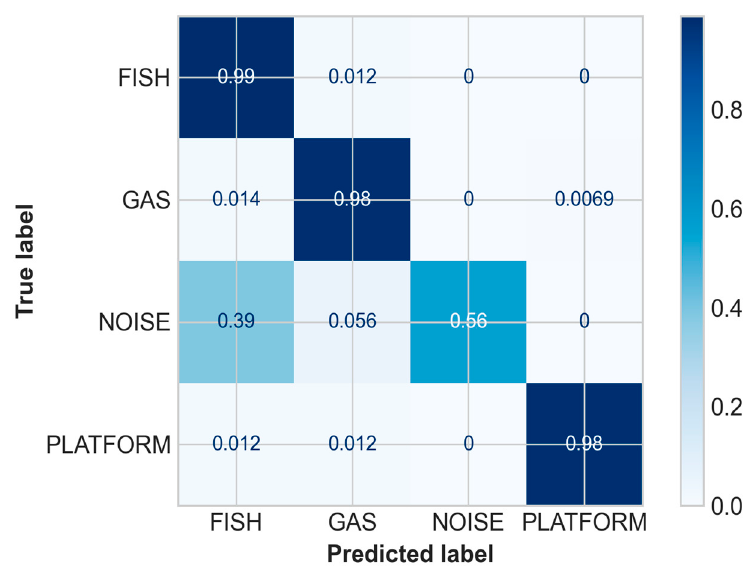
Figure 11. Confusion matrix of the pseudo-labelling. Table 3. Classification report for the pseudo-labelling.